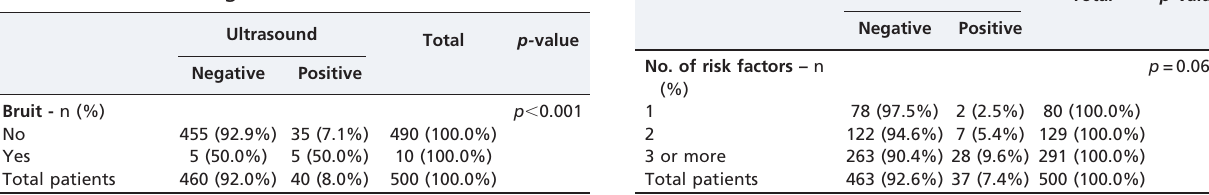
Table 3 - Comparison of the presence of carotid bruit and carotid stenosis findings on ultrasound.